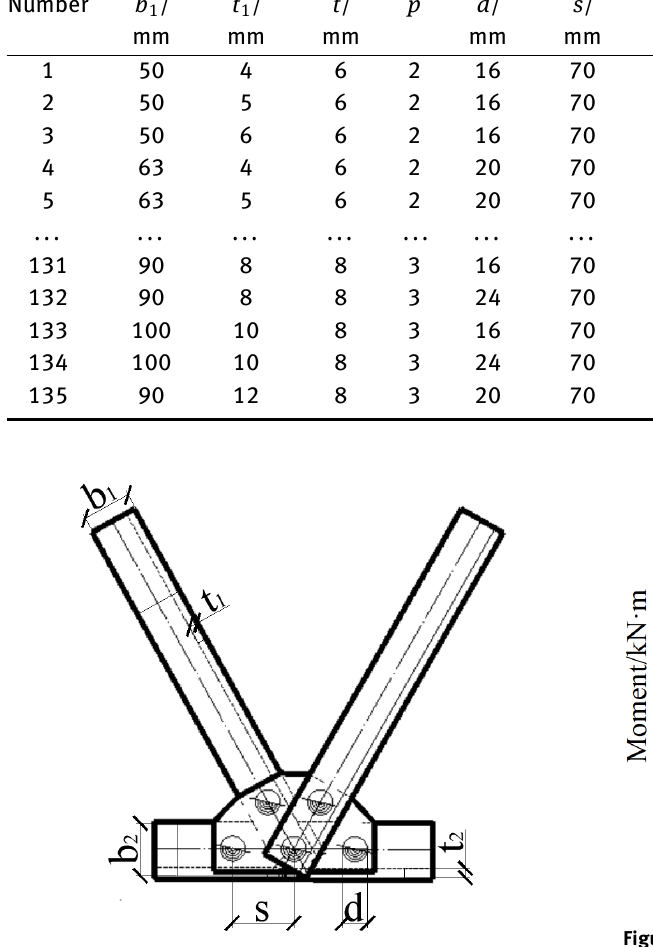
Figure 11: Some of the model parameters where x is the parameter which need to be fitted, e is the natural constant.